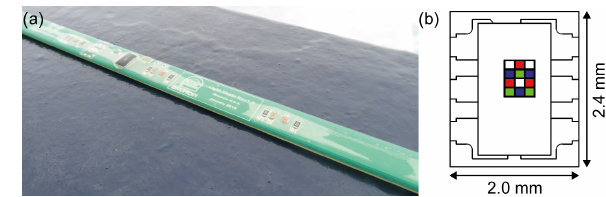
Figure 1. (a) A segment of the chain prototype during the calibra- tion procedure. The optical sensors are visible as red-colored com- ponents on the circuit board. The black addressing chip controlling the sensors of a particular chain section can be seen in the middle of the picture. (b) Sketch of the arrangement of the different spectral channels on the three-by-four photodiode array of the